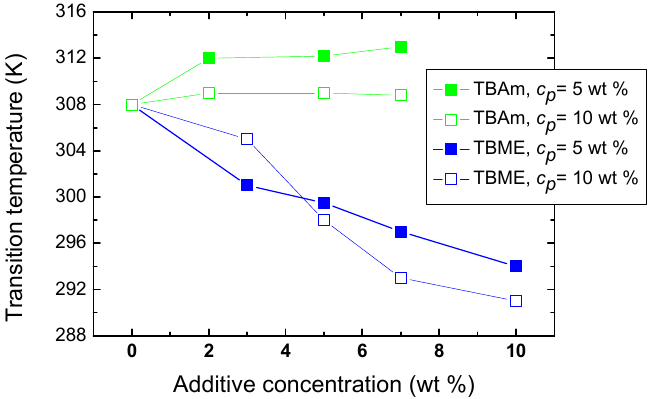
Figure 5. Concentration dependence of the transition temperature for PVME/TBME and PVME/TBAm solutions for two various polymer concentrations c P = 5 and 10 wt % PVME in D 2 O.